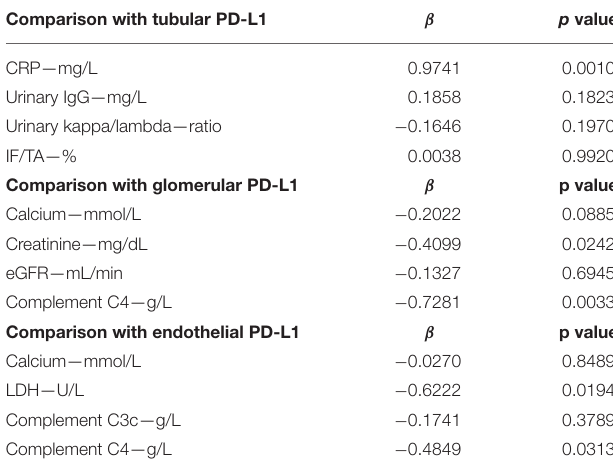
TABLE 2 | Linear regression analyses of